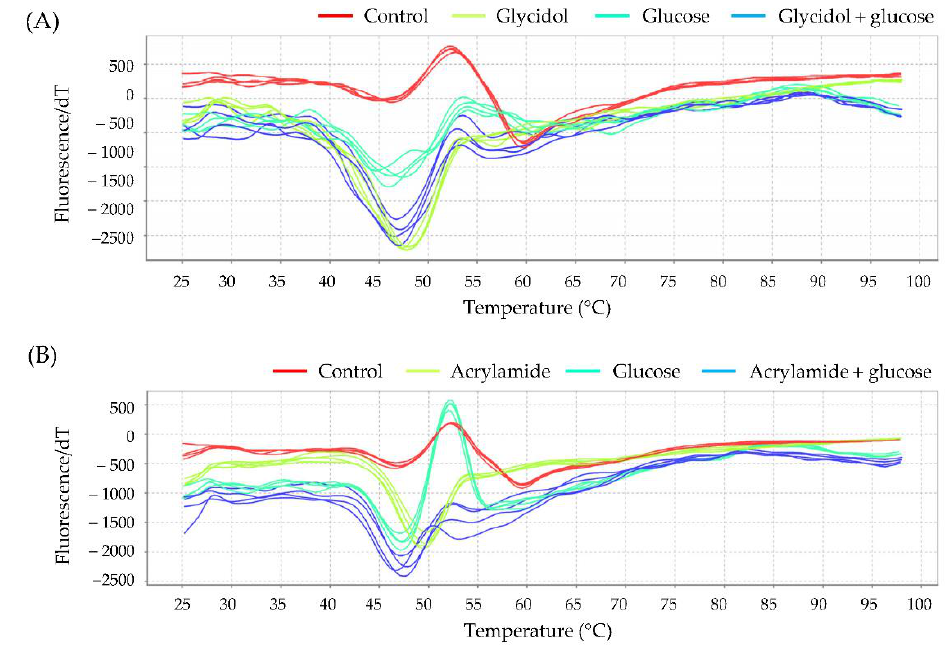
Figure 8. Melting profiles of hemoglobin (Hb) in the presence of glucose and ( A ) glycidol or ( B ) acrylamide. The figures show the profile of the derivative of fluorescence emission as a function of temperature (dF/dT). Glycidol or acrylamide was added after the preincubation of Hb and glucose.